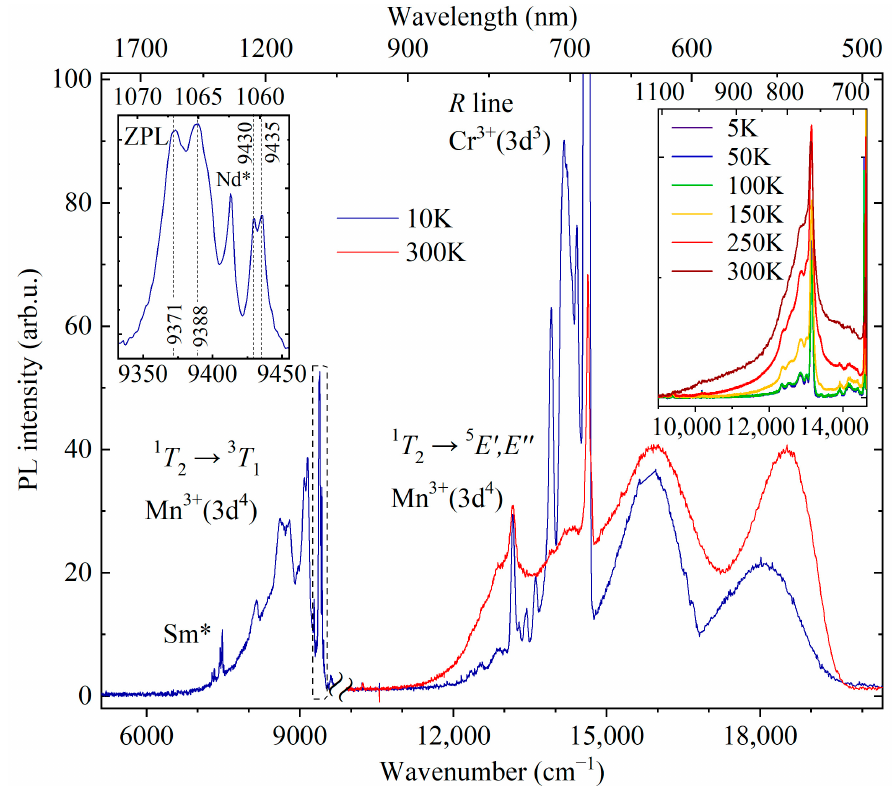
Figure 5. PL spectrum of YAB:Mn in a broad spectral range. The break separates the parts of the spectrum recorded on the Bruker IFS HR125 spectrometer (5100–9900 cm − 1 at 10 K, λ ex = 450 nm) and on the OceanInside HDX spectrometer (9900–20,500 cm − 1 at 10 and 300 K, λ ex = 488 nm). The left inset shows the region of zero-phonon lines in an enlarged scale. The right inset presents the region around the line 13,160 cm − 1 at different temperatures (5–300 K, Bruker IFS HR125 spectrometer). The lines due to uncontrolled Sm 3+ and Nd 3+ impurities are marked as Sm* and Nd*, respectively.